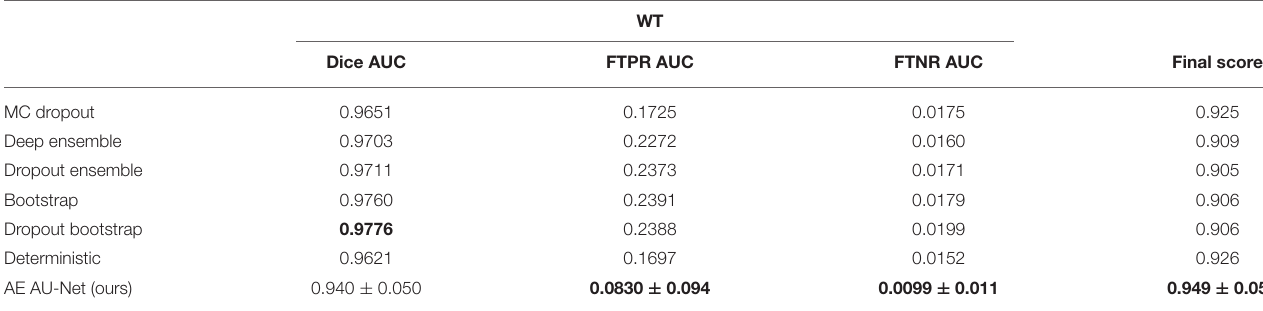
The online BraTS evaluation platform computed metrics. The Dice coefficient area under the curve (Dice AUC), filtered true-positive ratio (FTPR), and filtered true-negative ratio (FTNR) are reported for the whole tumor (WT). Bold values highlight the best results for each metric.